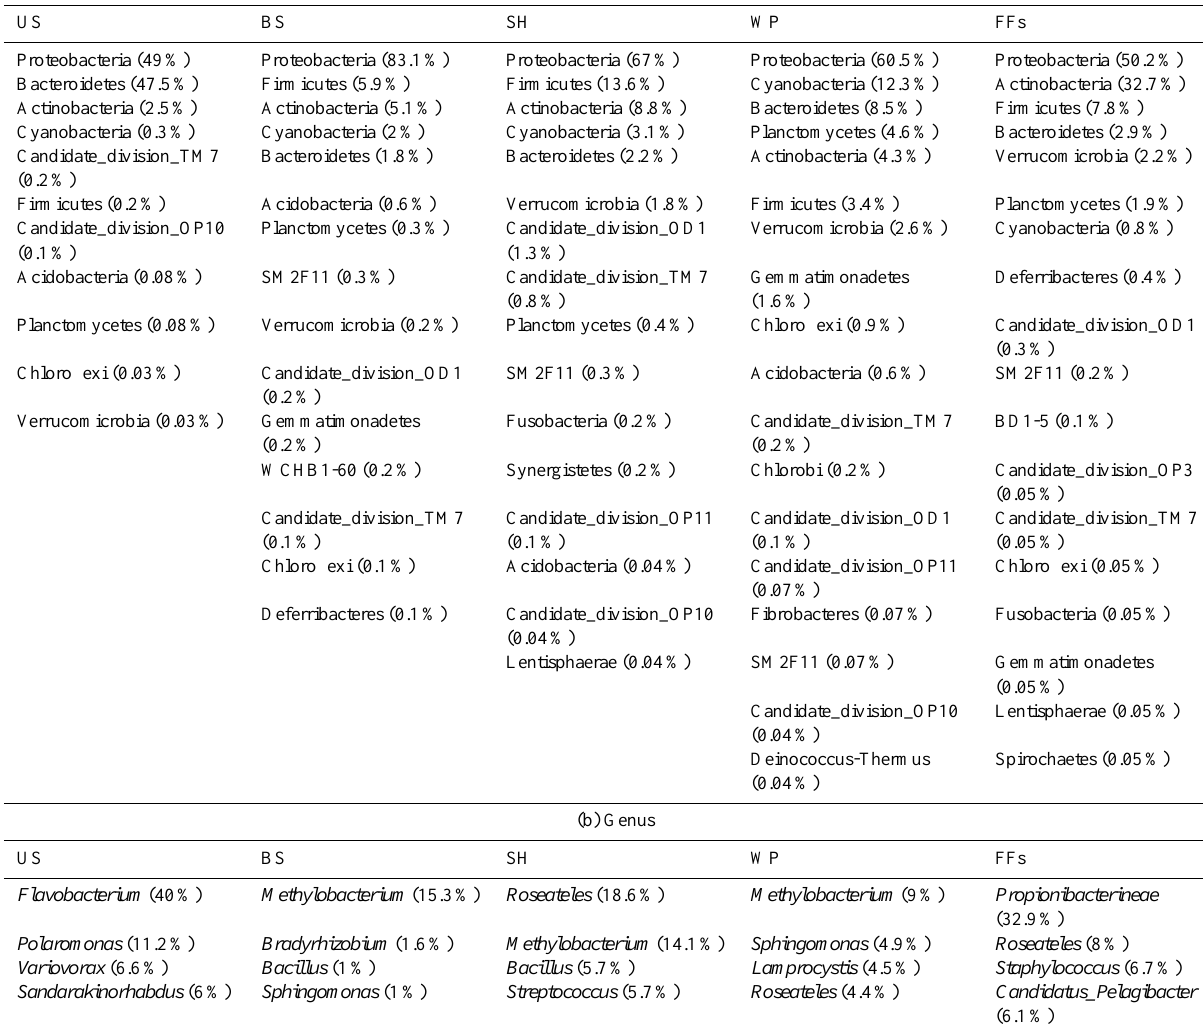
Table A1. Relative abundance of bacterial taxa detected by Roche 454 GS-FLX Titanium using 16S rDNA gene. Detected phyla (a) and the top four genera with the highest percentage (b) in each Arctic sample: blowing snow (BS), surface hoar snow (SH), windpack snow (WP), frost flowers (FFs); and urban snow (US). The number in parenthesis shows the sequence percentage obtained from the overall bacterial